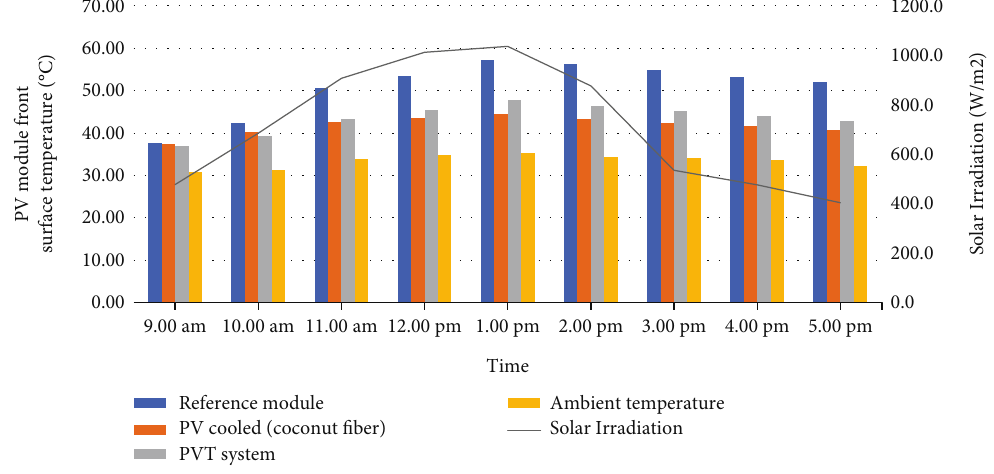
Figure 4: Variation of solar irradiation, ambient temperature, and PV module front surface